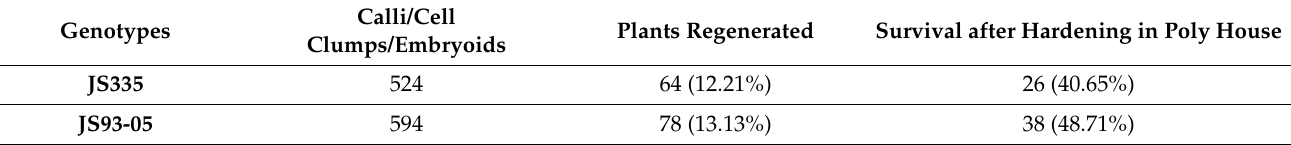
Table 6. Regeneration frequency and survival percentage of soybean tolerant calli/cell clumps/ embryoids against drought. Genotypes